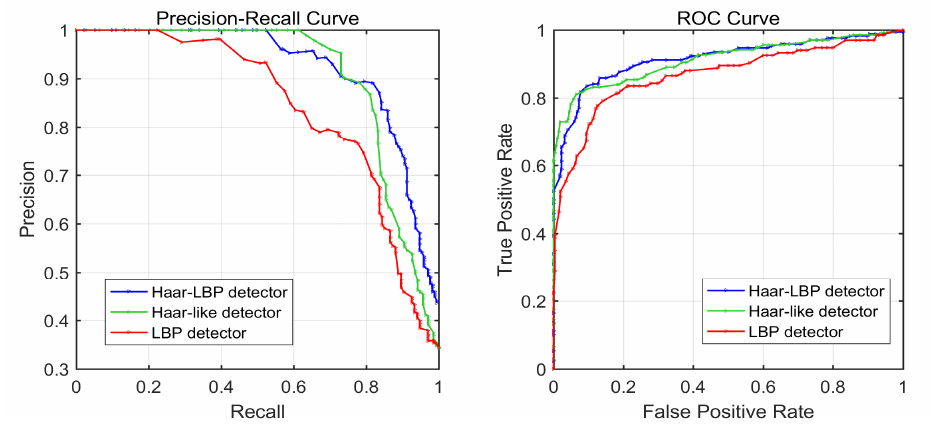
Figure 12. ROC curves and PR curves for the Haar–LBP detector (blue), Haar-like detector (green), and LBP detector (red) applied to the testing set. In the two graphs, the curve trends of the three detectors are similar. Table 2. AUC value of the three detector curves.